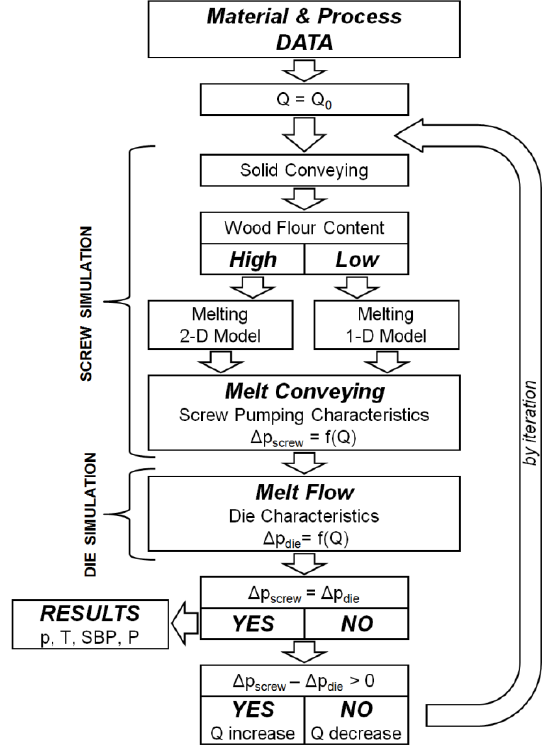
Figure 8. Scheme of computations: Q — flow rate, Q 0 — initial flow rate, p —pressure, Δp screw — total pressure in crease in the screw, Δp die — total pressure drop in the die, T —temperaturę, SBP— melting profile (Solid Bed Profile), P — power consumption.